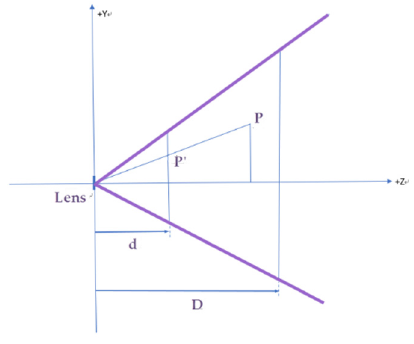
Figure 4. Line of sight scenario of CCTV.